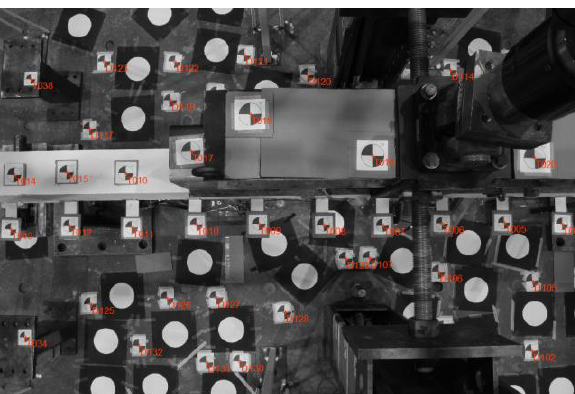
Figure 5. Example of the distribution of signalized targets on the floor, the concrete beam, and the spreader beam for the relative orientation estimation before the static loading